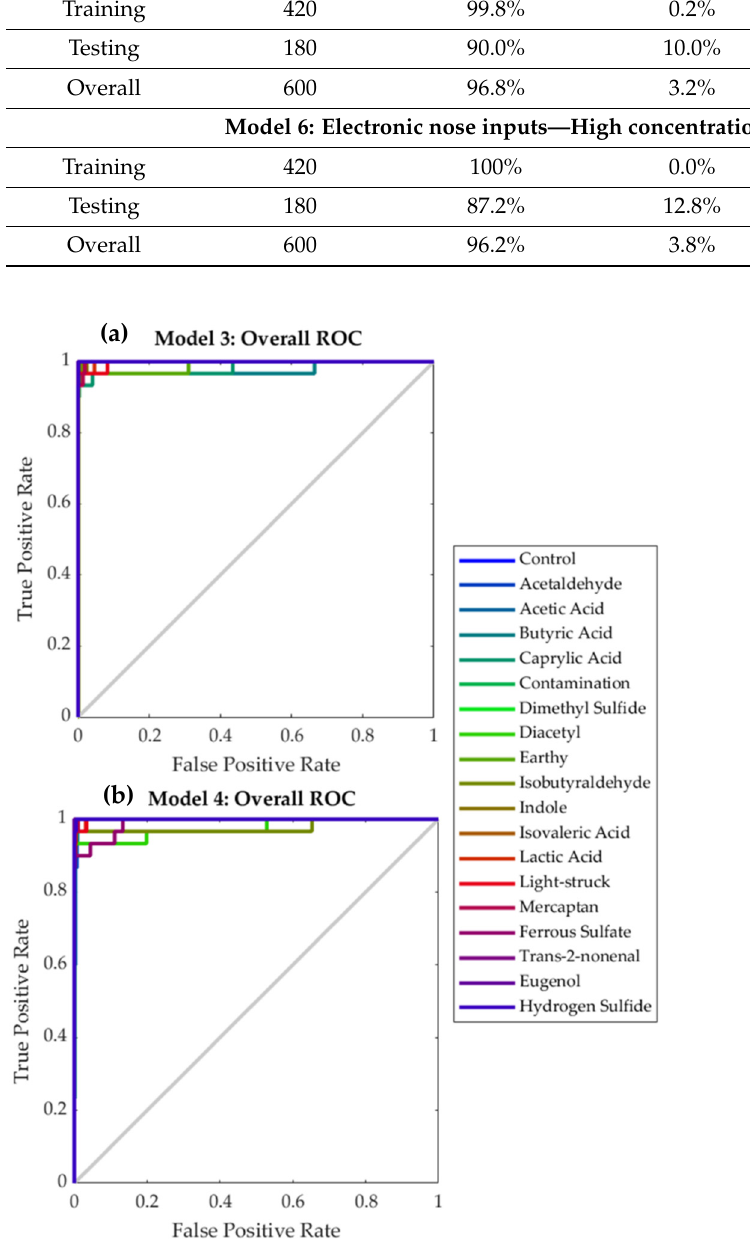
Figure 9. Receiver operating characteristic (ROC) curves for the ( a ) low (Model 5) and ( b ) high (Model 6) concentration samples to classify beers according to the faults present in them using the electronic nose outputs as